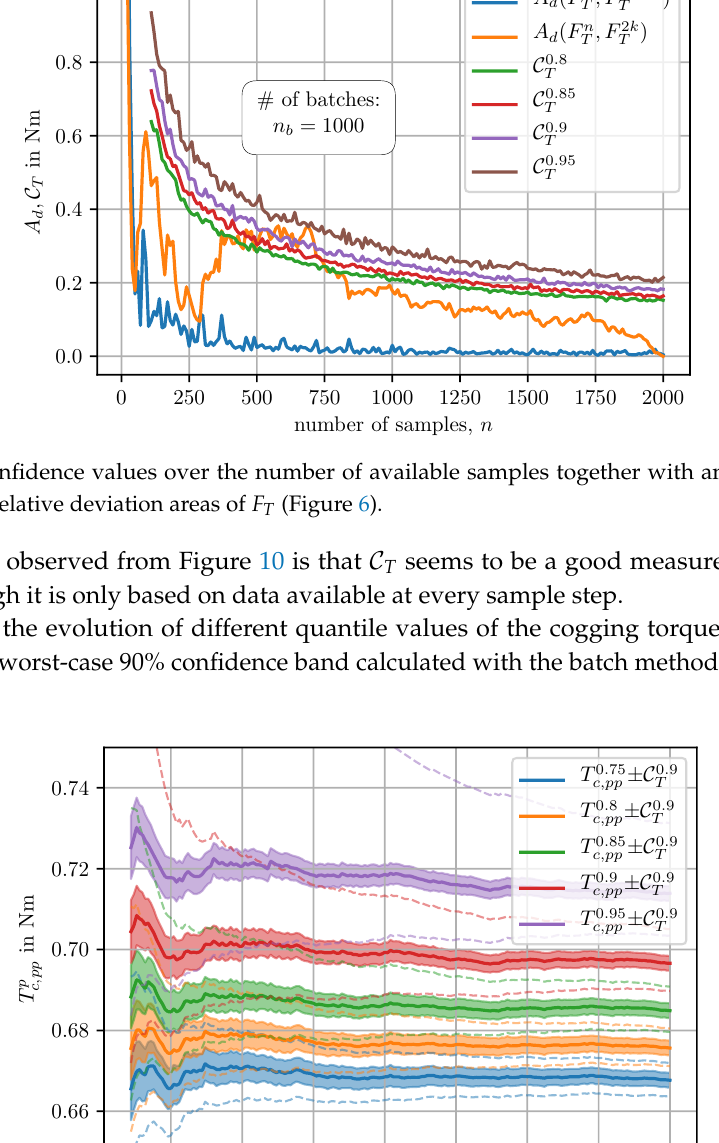
1 , 1 L 0.9 U 0.9 − − (cid:0) (cid:1) (cid:0) (cid:1)